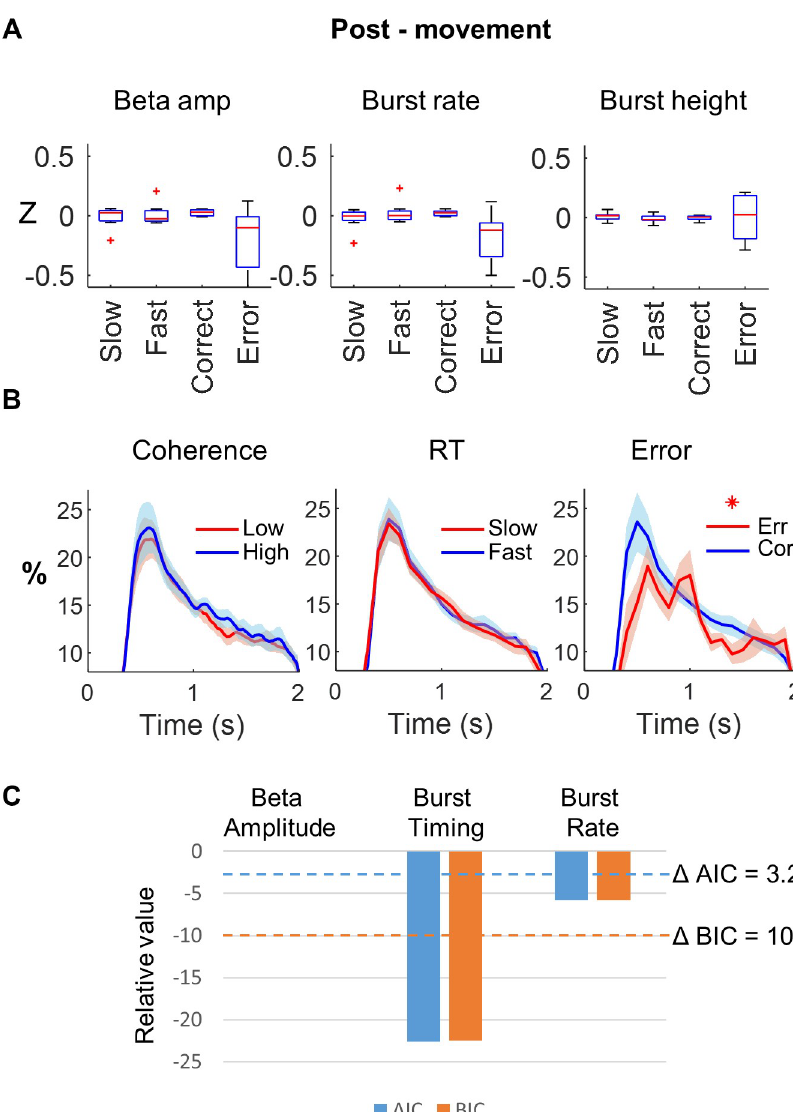
Fig 8. Relationship between beta and errors post-movement. (A) Post-movement beta amplitude, burst rate, and burst height, z-score normalised within subject and split according to trials, with slow versus fast response times and correct versus incorrect trials. Note the decrease in beta amplitude and burst rate on error trials, although this was not significant following FDR correction. (B) Post-movement, there was no significant difference between beta bursts on low and high coherence trials (left panel) or slow versus fast trials (middle panel). Conversely, burst probability ( � p FDR < 0.05) was higher for correct (blue) versus error (red) trials across all subjects. The difference at the first peak (600 milliseconds) was nonsignificant following FDR correction, whereas the second peak at 1.4 second remained significant. On the time axis, zero represents the motor response time. Data are down-sampled to 20 Hz. (C) Model comparison of three separate linear mixed effects models incorporating one of single trial beta amplitude (1), beta burst timing (2), and burst rate (3) for response accuracy in the post-movement periods. The burst timing model shows a significantly lower AIC/BIC compared with the beta amplitude model ( Δ AIC = − 24) and ( Δ BIC = − 24) for the post-movement period, confirming that burst timing is a better predictor of response accuracy than average single trial beta amplitude. The underlying data can be found at https://osf.io/eu6nx/. AIC, Akaike information criterion; BIC, Bayesian information criterion; FDR, false discovery rate; RT, response